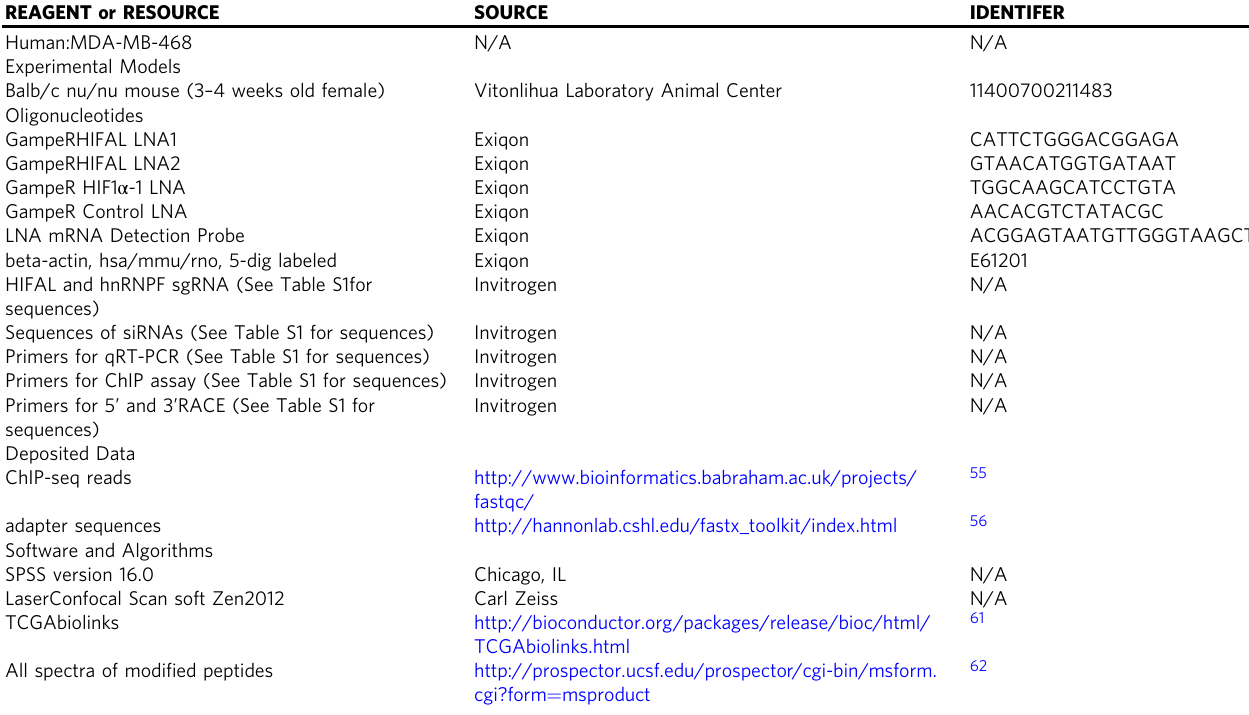
(Promega, WI, USA). The division of fi re fl y luciferase activity with renilla luciferase of the same sample was calculated to get the transfection ef fi ciency in order to normalize the data. The mutation was generated as following: wt: … TGCGCCCGAG CACGT ACTGAGG CGTG GCCTGCCGCGCGCCG